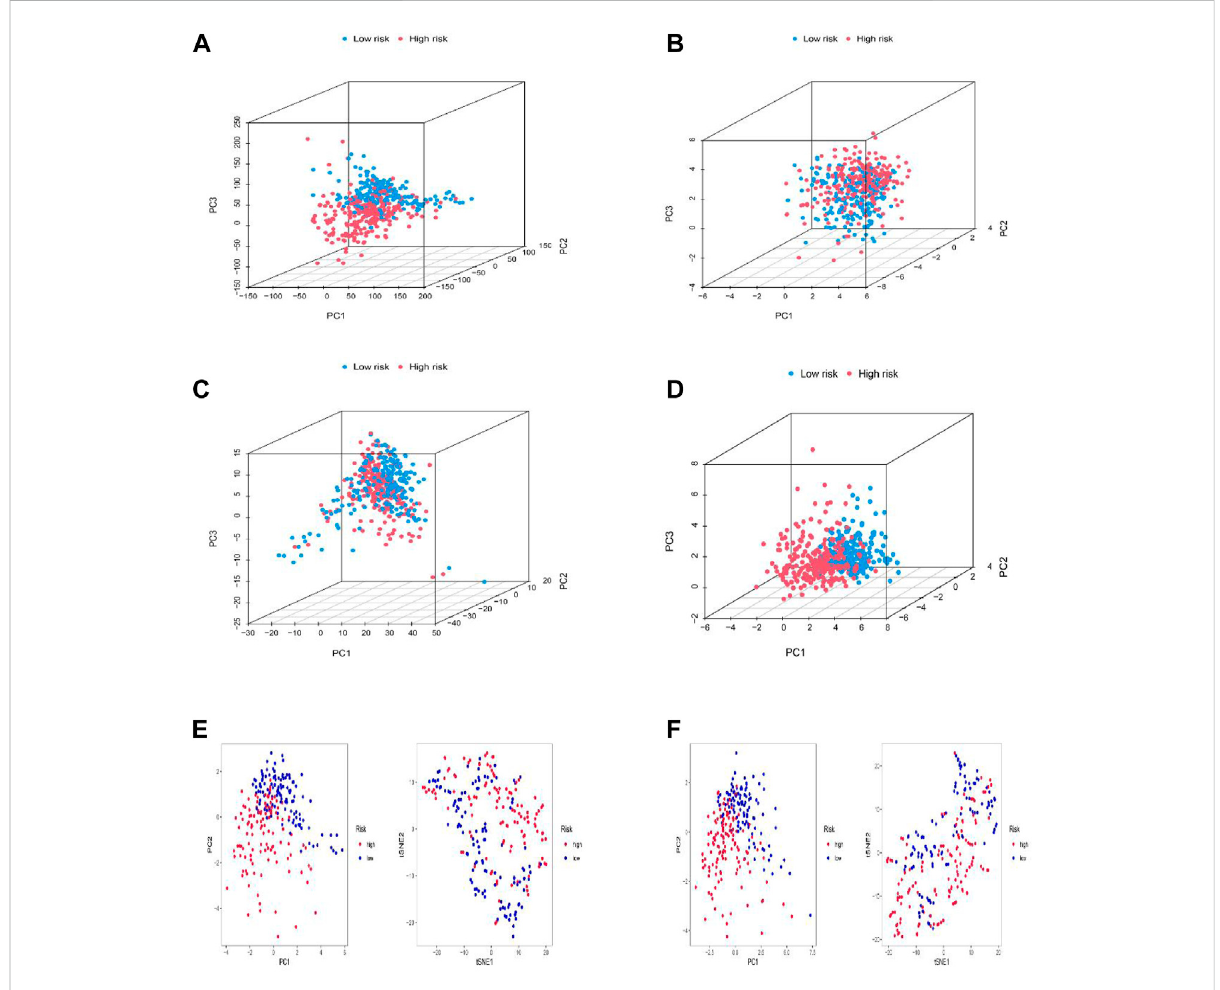
FIGURE 5 Principal component analysis. (A – D) PCA analysis between the high and low-risk based on the whole genome expression set (A) , 10 cuproptosis-related genes (B) , 1272 cuproptosis-related lncRNAs (C) , and risk model classi fi ed by the expression pro fi les of the six cuproptosis- related lncRNAs (D) . (E,F) PCA and t-SNE analyses between the high and low-risk groups in the training (E) and testing sets (F)